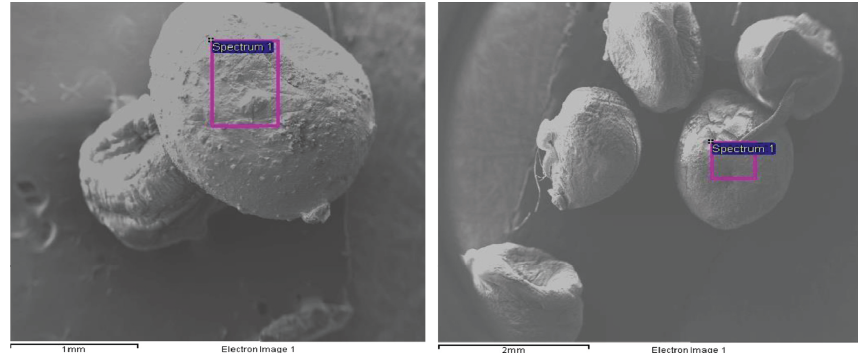
Figure 6: Electronic images of the adsorbent (HRMCAB) before and after lead adsorption.